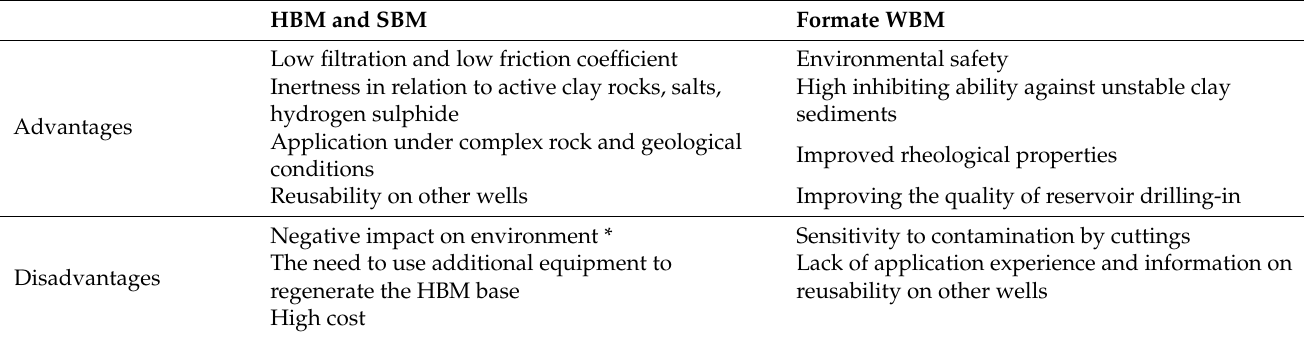
Table 1. Comparison of HBM and SBM with formate